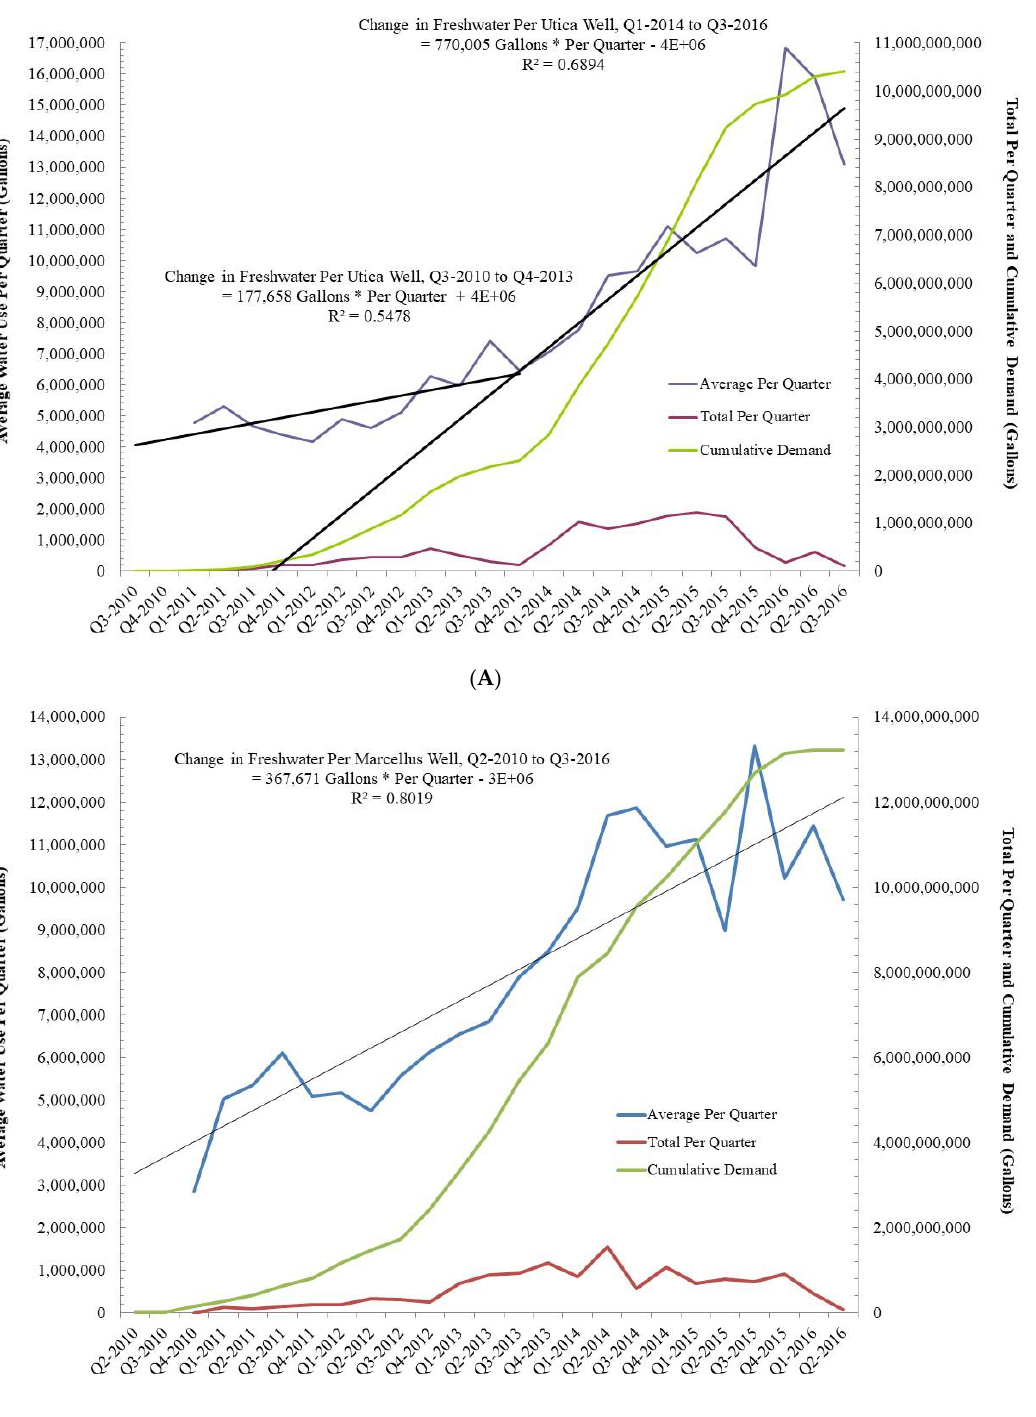
Figure 5. Ohio ( A ) and West Virginia ( B ) hydraulic fracturing freshwater demand in total and per well between Q3-2010 and Q3-2016.